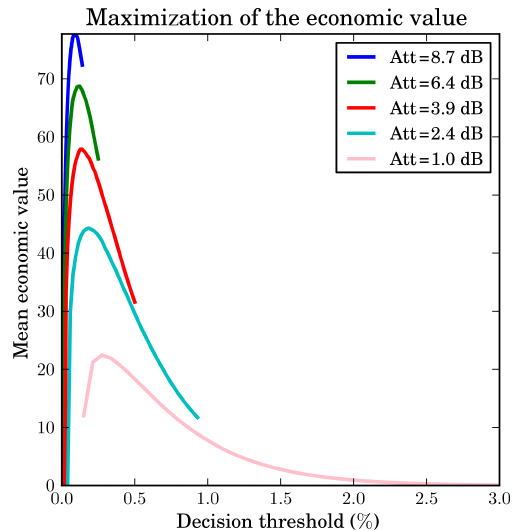
Figure 10. Evolution of the mean economic value as a function of the decision threshold used to discriminate between positive and negative forecasts. The mean economic values have been obtained averaging the economic values computed following Eq. (4) for a simulation period of 2 years